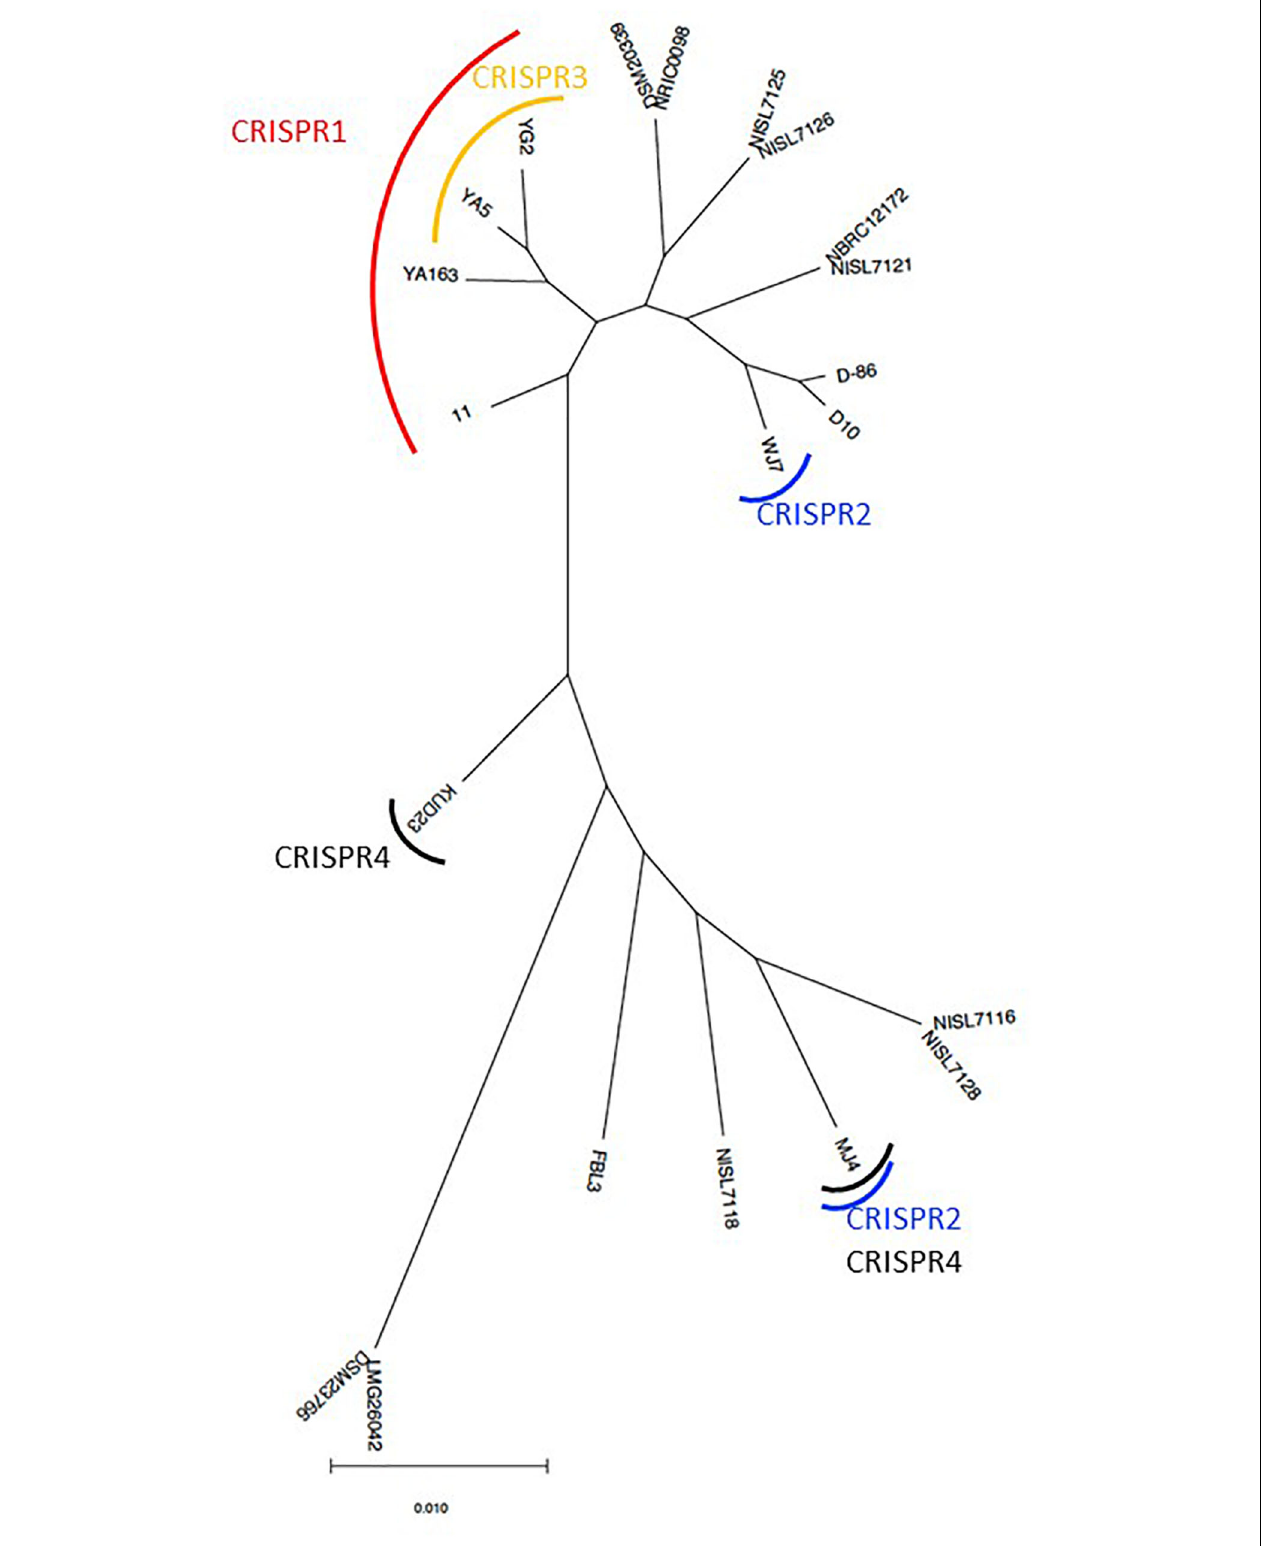
FIGURE 4 | Maximum-likelihood phylogenetic tree of 22 Tetragenococcus halophilus strains. The tree was prepared based on the nucleotide sequences from 1,292 orthologous gene sets. The strains that retained CRISPR loci in the genome sequence are indicated by a curved line.